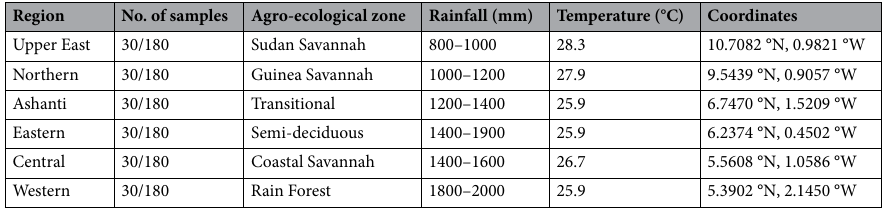
Table 1. Geographical locations and some attributes of the origin of